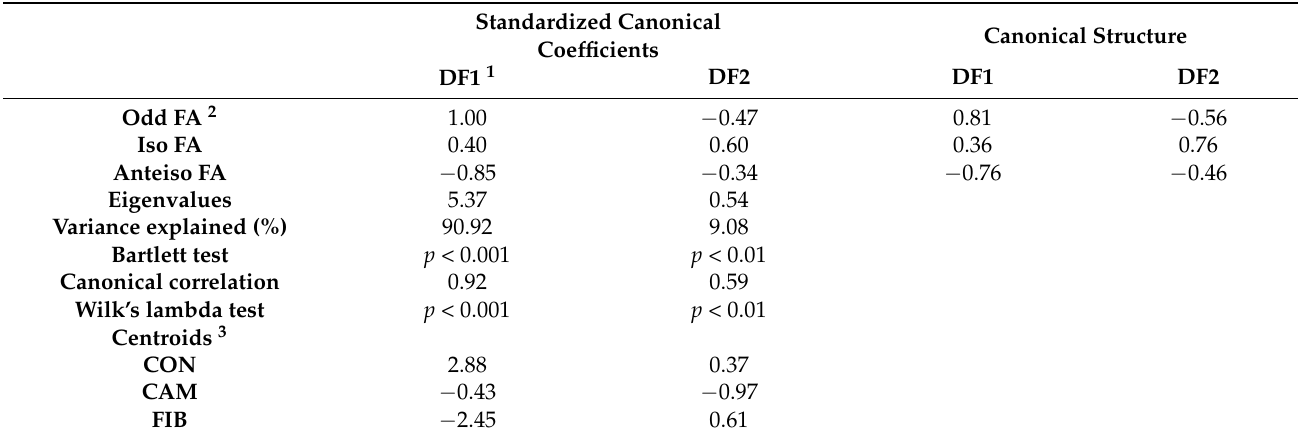
Table 2. Canonical discriminant analysis results.